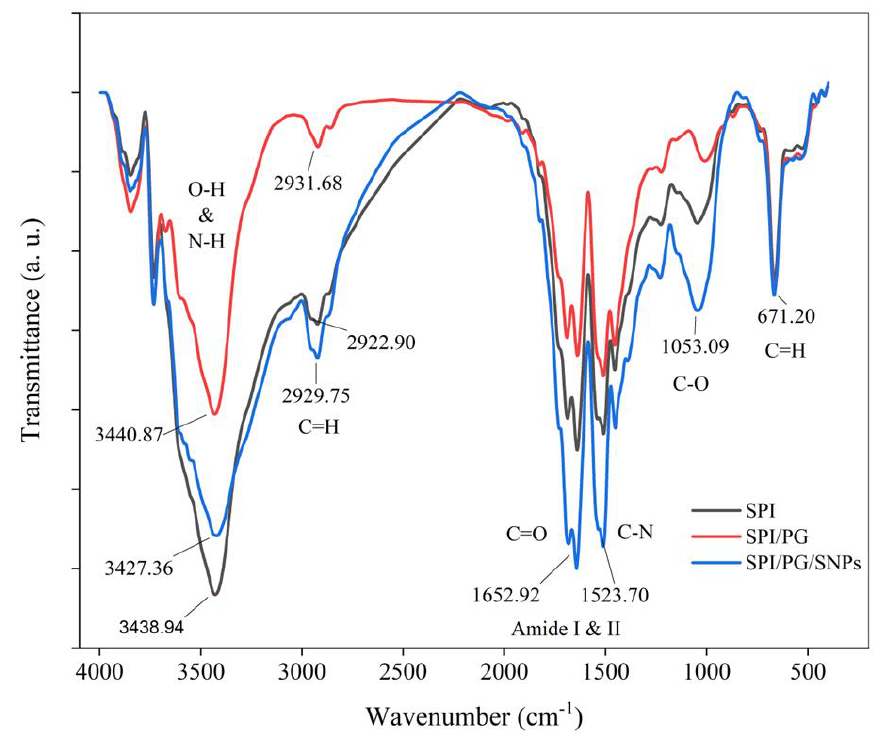
Figure 3. FTIR spectra of SPI, SPI/PG, and SPI/PG/SNPs films.